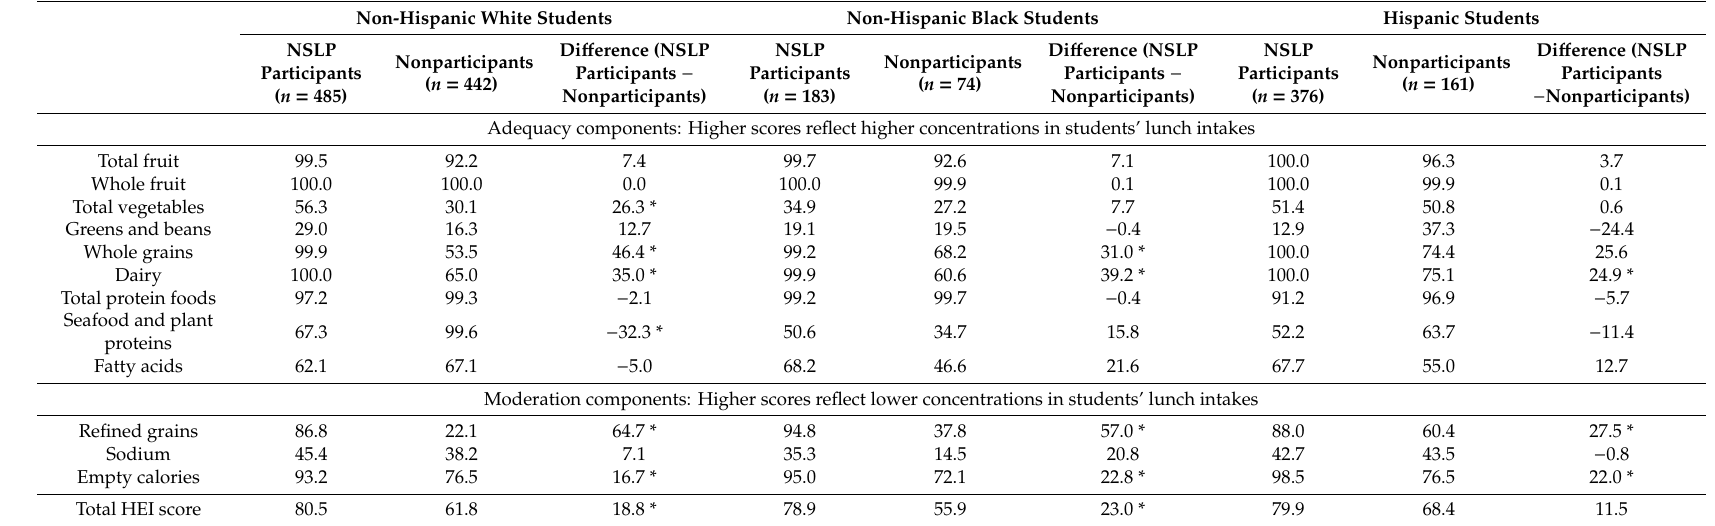
Table 5. Di ff erences between NSLP participants and nonparticipants in mean HEI-2010 scores for lunch intakes, by race / ethnicity. Non-Hispanic White